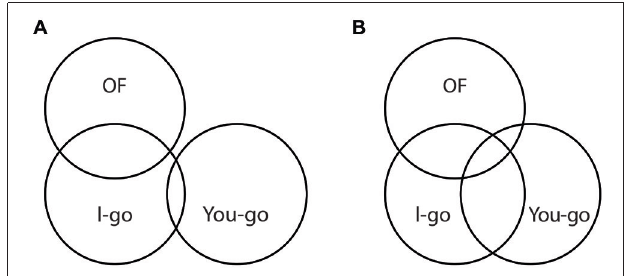
FIGURE 5 | Interaction between (vertical) face/agent and (horizontal) self/other overlap . Due to vertical overlap between stimulus and response codes, a photo of one’s own face ( OF ) primes one’s own Go response ( I-go ). As long as horizontal overlap between response codes is weak the competing code ( You-go ) is unaffected by the vertical overlap (panel A , unfamiliar co-actors). However, when horizontal overlap is substantial, one’s own face will also prime the competing code ( You-go ; panel B , familiar